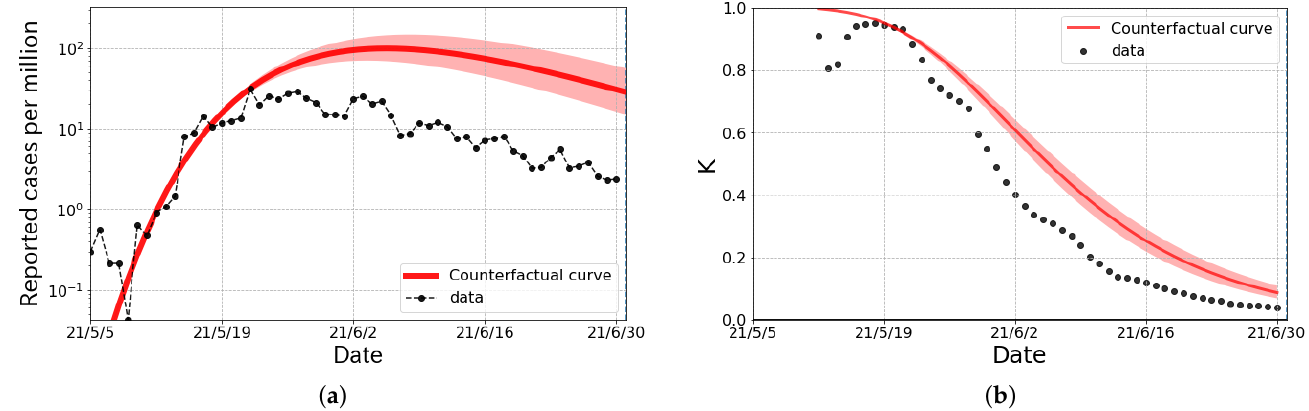
Figure 4. The logarithmic plot and the K-value of the counterfactual hypothesis curve in the Alpha surge in Taiwan. ( a ) The reported cases per million and the counterfactual curve (solid line) which is drown by changing the k from 0.895 to 0.920, which is the typical value in Japan [17,18]. ( b ) The observed data and the counterfactual curve of the K-value. The red bands stand for the fluctuations with the ± 0.05 changes in k